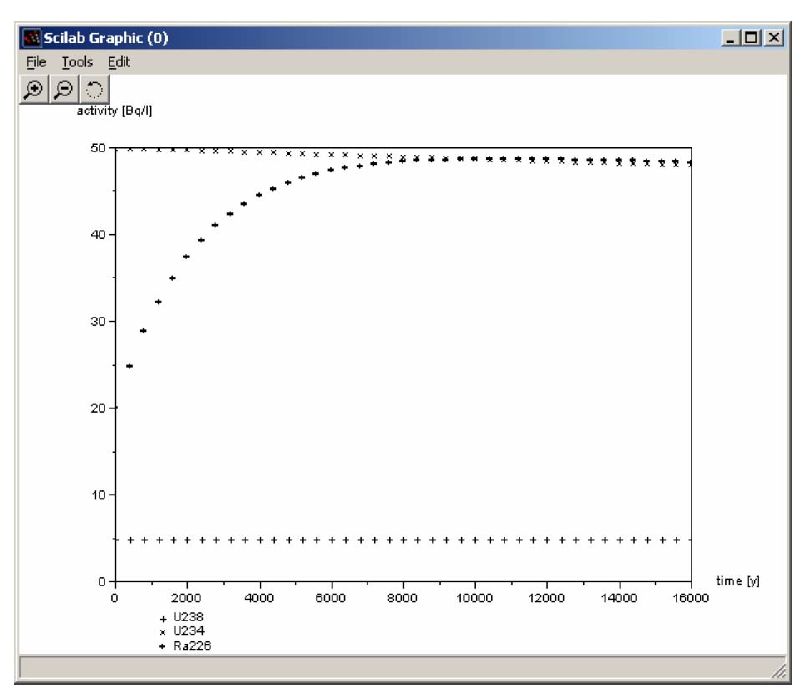
Fig. 2 Time dependence of the activity of three genetically coupled radionuclides from uranium decay series 4n+2 calculated by the elaborated method.